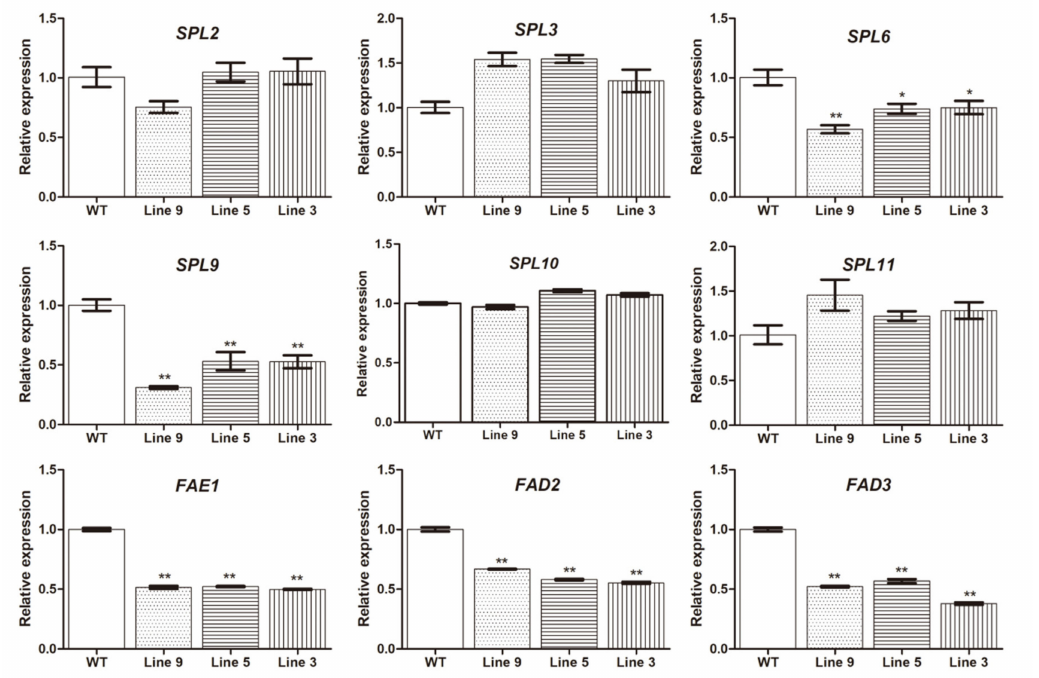
Figure 7. Expression levels of SPL genes and seed oil synthesis genes in the over-expression Arabidopisis transgenic lines and WT. Line 9: Lus-MIR156a-OX9, Line 5: Lus-MIR156a-OX5, Line 3: Lus-MIR156a-OX3. * p < 0.05 and ** p < 0.01 indicated significant di ff erences with